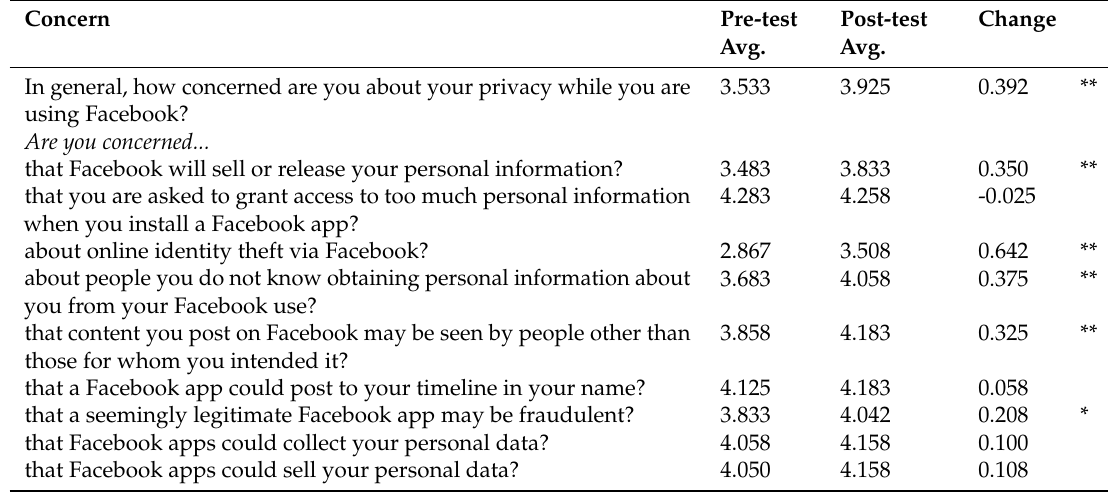
Table 2. Answers pre- and post-test to questions about concern Facebook apps. Values are on a 5-point Likert scale ranging from “Not at all” (1) to “Very much” (5). Significant increases are marked * for p < 0.05 and ** for p < 0.01.